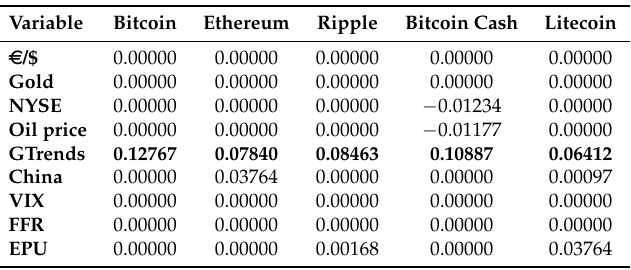
Table A9. PC-LASSO coefficients for recovery